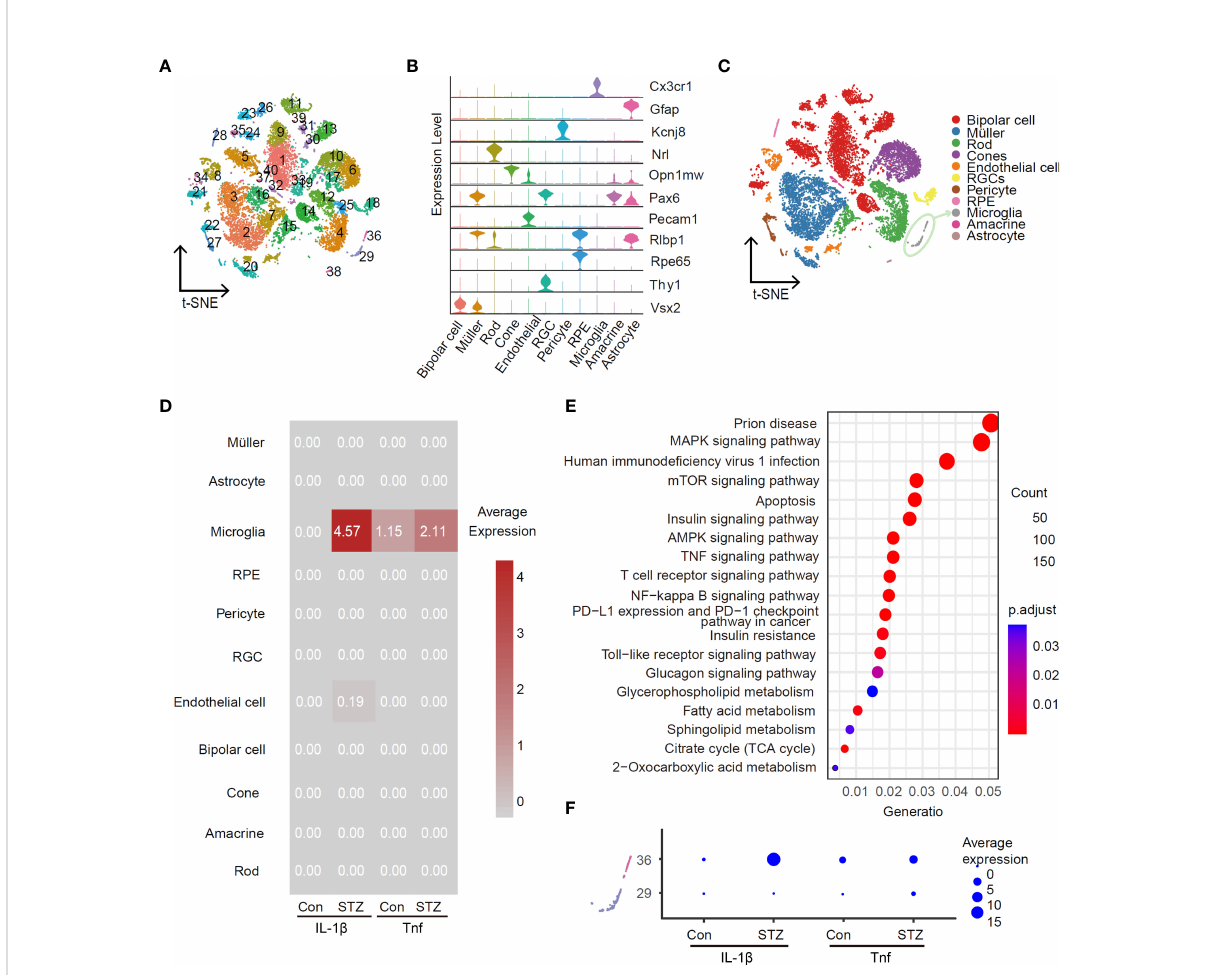
FIGURE 2 Activated retinal microglia is the main source of IL-1 b in the retina of STZ-induced DR mice. Feature plot in the t-SNE map of retina cells from healthy and STZ-induced diabetic mice revealing forty clusters (A) and eleven cell types (C) by scRNA-Seq program (after quality control, there were 6,126 cells in the control group and 7,851 in the STZ group). RGC, retinal ganglion cell; RPE, retinal pigment endothelial cell. (B) Violin plot of top marker genes for each cell subgroup. (D) Average expression of IL-1 b and Tnf from the control and STZ groups in all subpopulations as visualized by heatmap. (E) KEGG enrichment analysis of differentially expressed genes in microglia cells between the control and STZ groups. (F) Average expression of IL-1 b and Tnf in microglia subclusters 29 and 36 from the control and STZ groups as visualized by